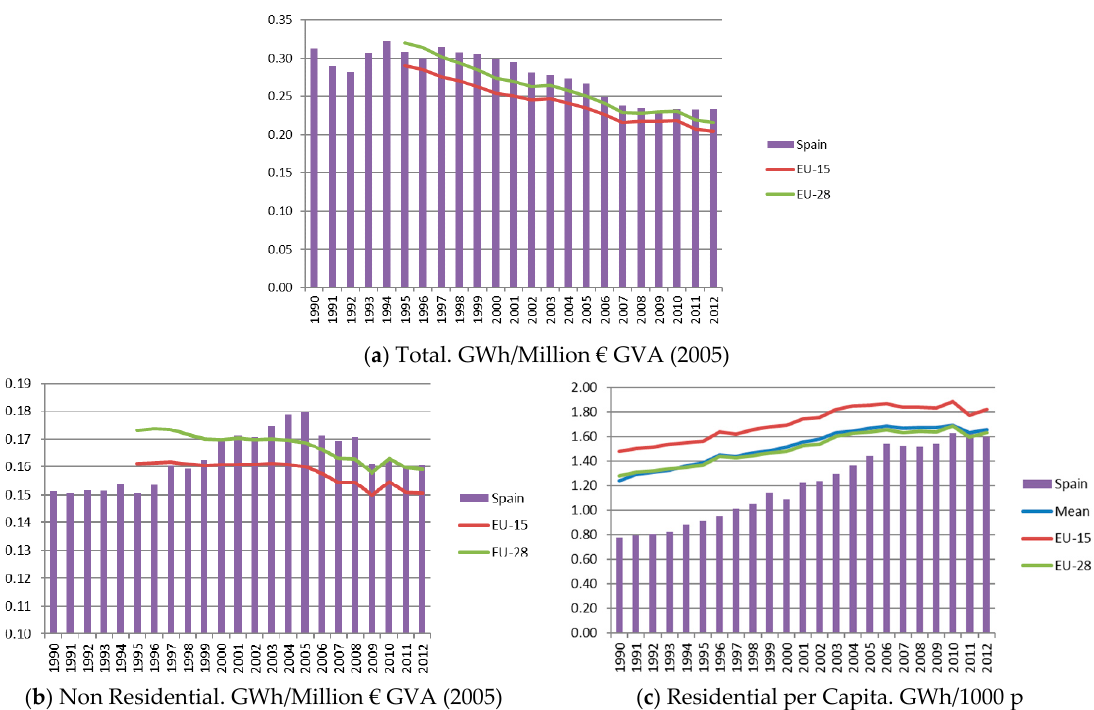
Figure 8. Intensity of electricity use (GWh/GVA and GWh per capita), 1990–2012. Source: Own calculation with Eurostat’s data.